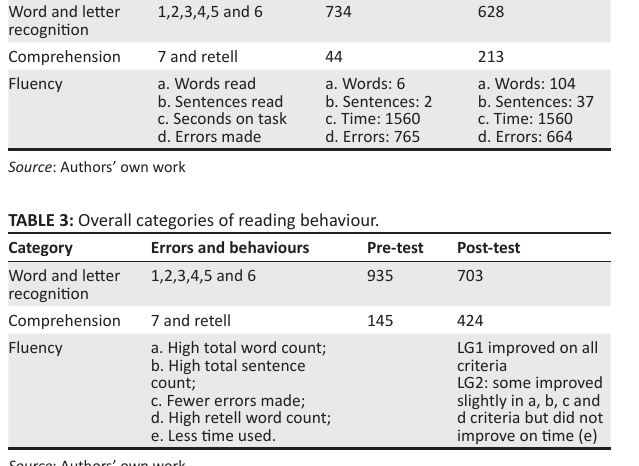
TABLE 2: Learner group 2 (LG2) categorisation of reading behaviours. Category